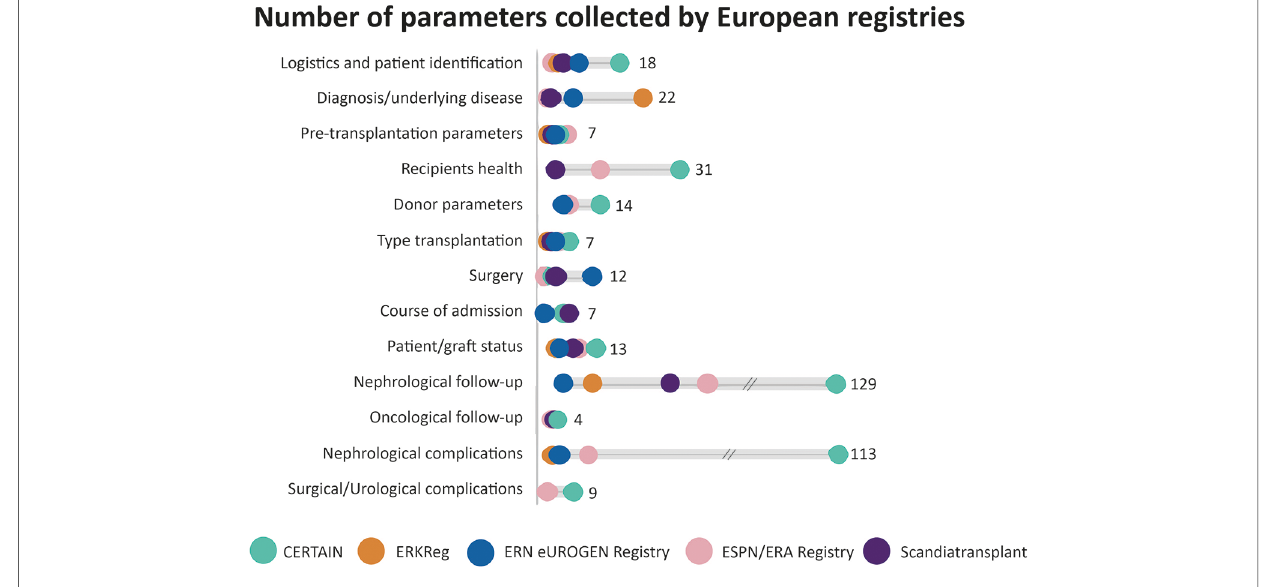
FIGURE 3 Number of parameters collected per topic per multinational European registry on paediatric kidney transplantation. CERTAIN, Cooperative European Paediatric Renal Transplant Initiative; ERKReg, European Rare Kidney Disease Registry; ERN, European Reference Network; ESPN/ERA, European Society for Paediatric Nephrology and European Renal Association.